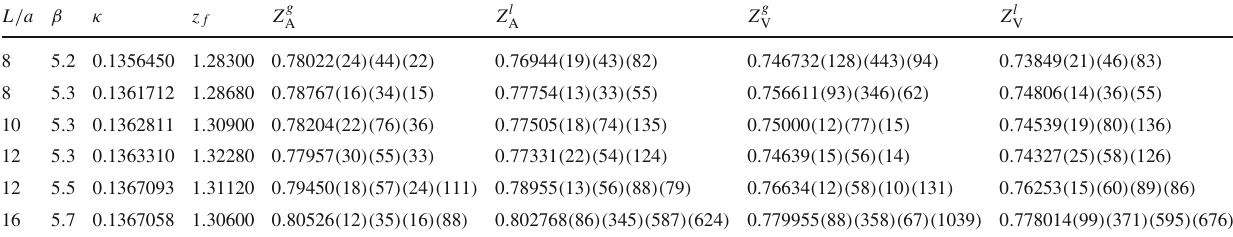
, l for the different N f = 2 coming from the uncertainty on z ∗ A , V ing from maintaining the condition (4.2) ( (cid:14) x Z A , V ); the latter is only Z A , V ), systematic relevant for the last two 0